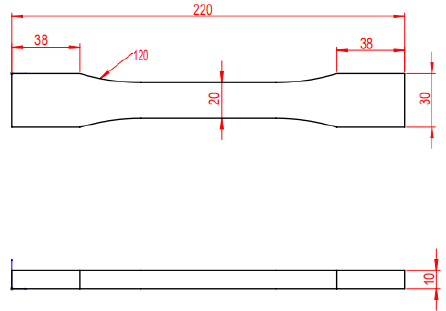
Figure 2. Geometry of the tensile specimens (mm).